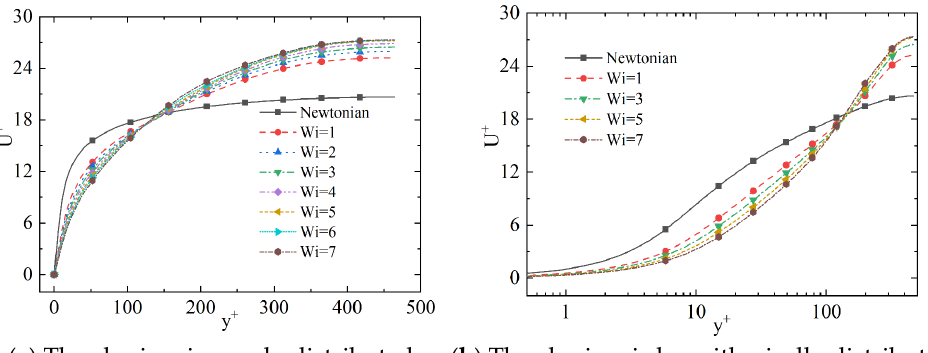
U ) of different Weissenberg numbers ( Wi ).